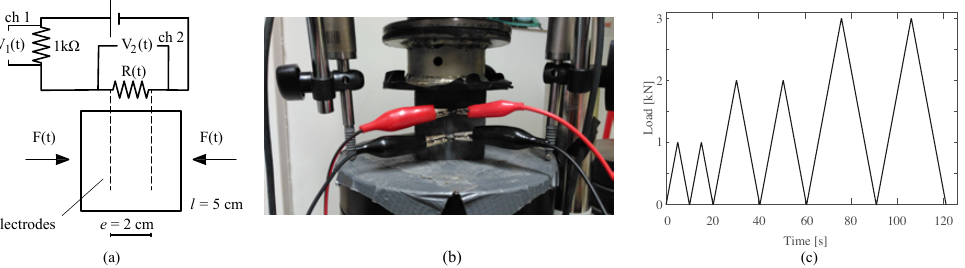
Figure 6. ( a ) The test setup formed by a cubic sample, load orientation, and equivalent electric circuit; ( b ) picture of experimental setup; ( c ) compression load pattern adopted for the tests.